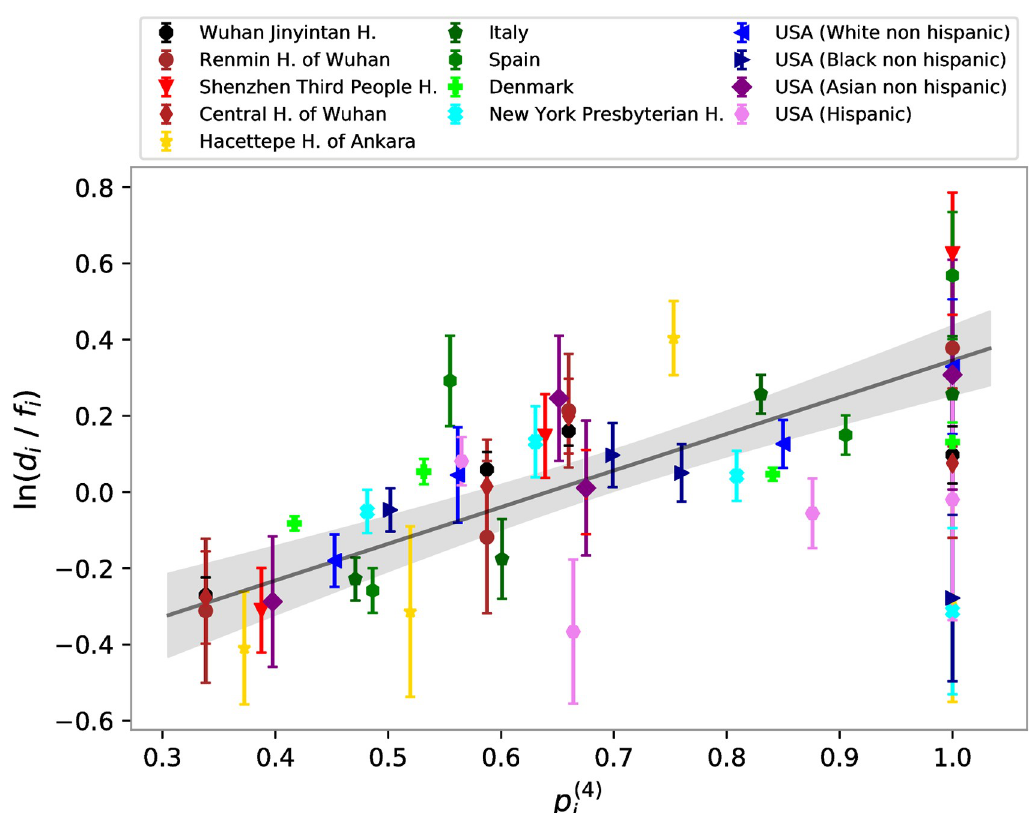
Fig 3. Ratio between frequencies of infected people for each ABO, d versus its theoretical prediction, p ð 4 Þ Table 1. Black line represents the best solution of a linear fit. The error bars on ln( d i / f i ) are one standard deviation calculated by assuming a Poissonian distribution for the number of cases, thus D ð ln ð d with blood type i